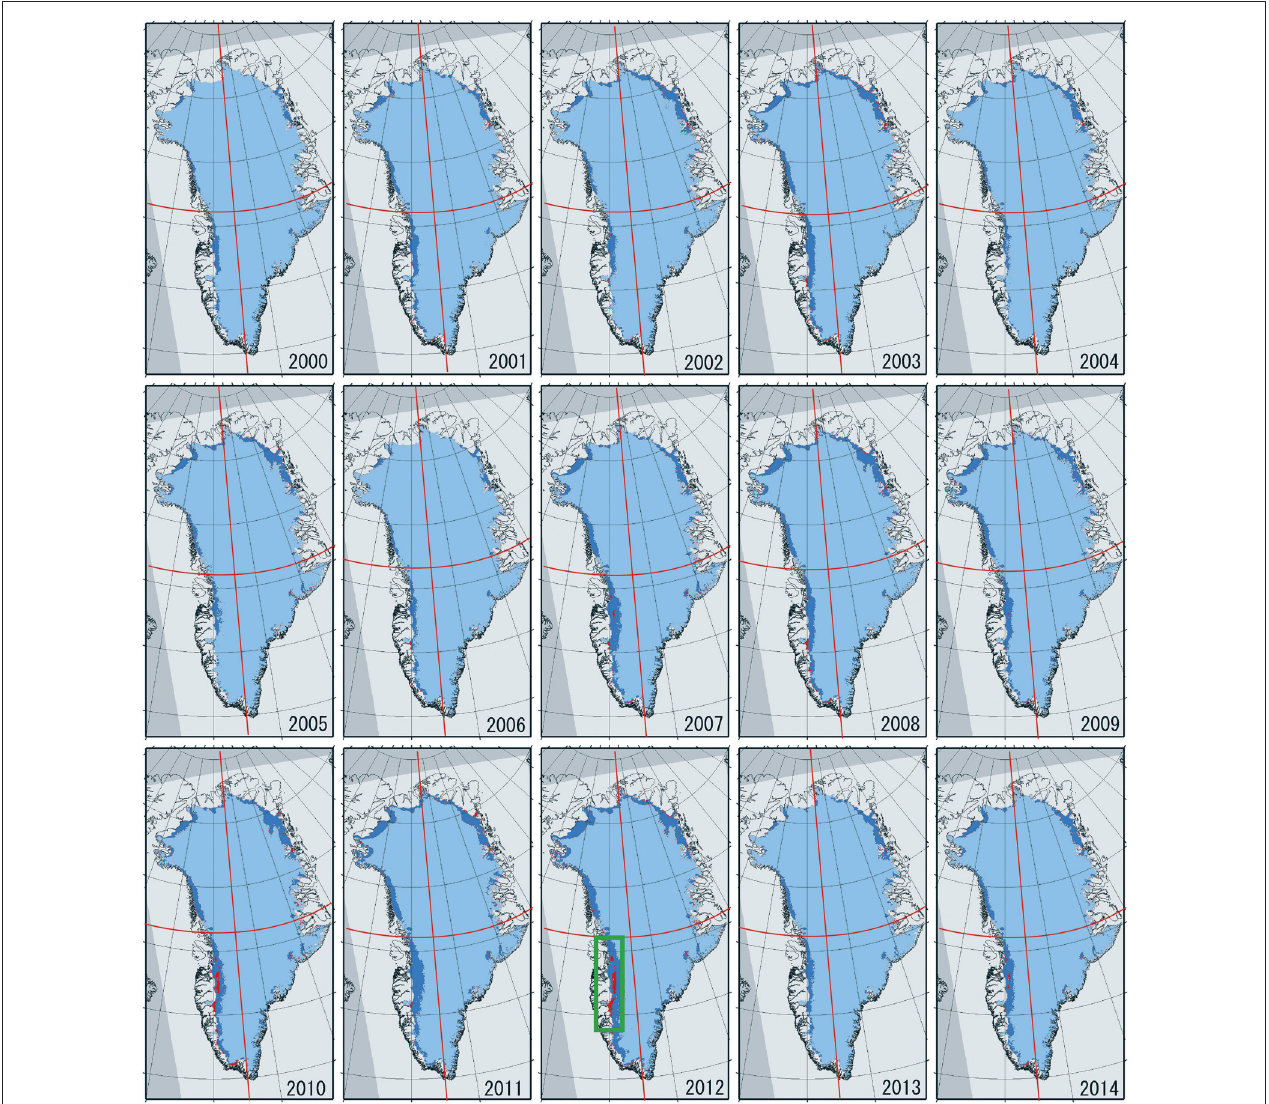
FIGURE 3 | Distribution of snow (light blue), bare ice (blue), and dark ice (red) in July from 2000 to 2014. Red lines are regional division (72.5 ◦ N and 45 ◦ W). Green frame in 2012 showed the dark band.